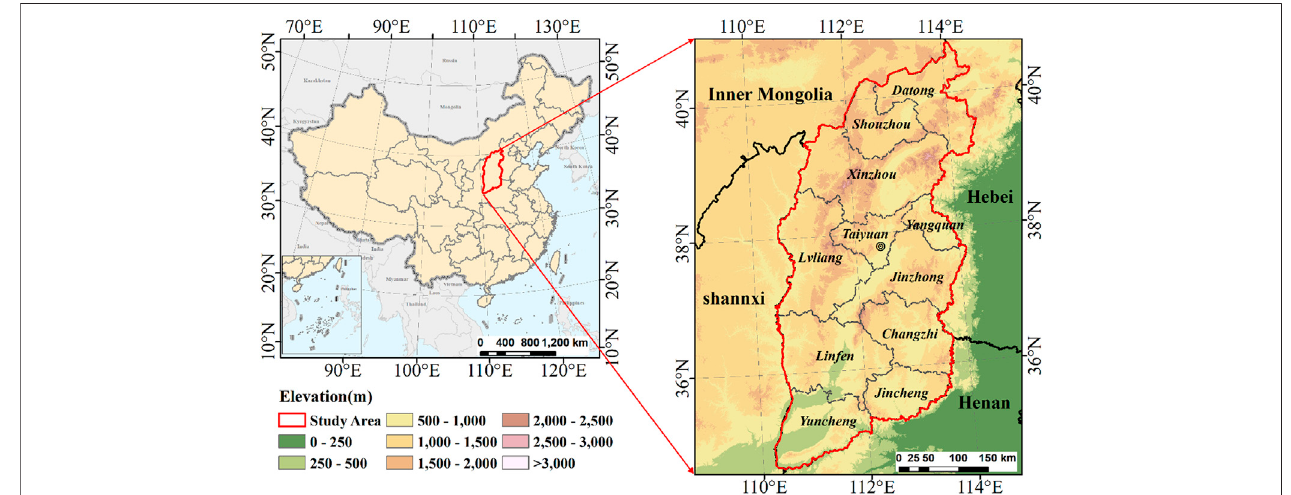
FIGURE 1 | Location of the study area (Shanxi